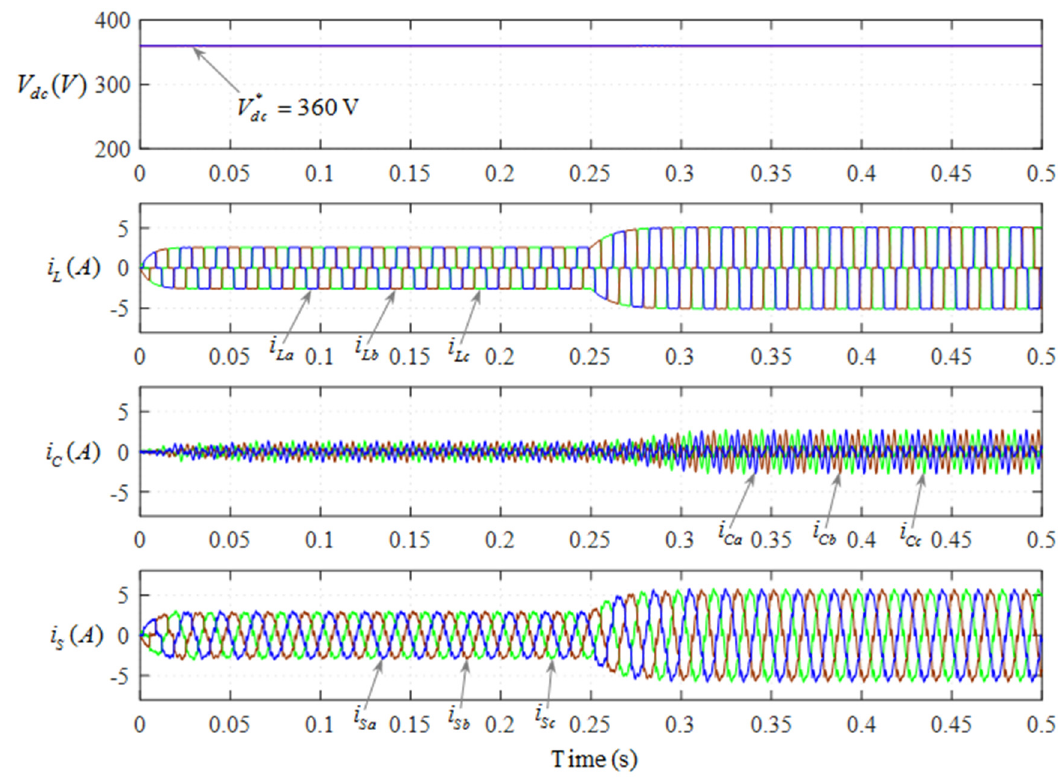
Figure 17. The DC bus voltage, the load current, the compensated current, and the source current.